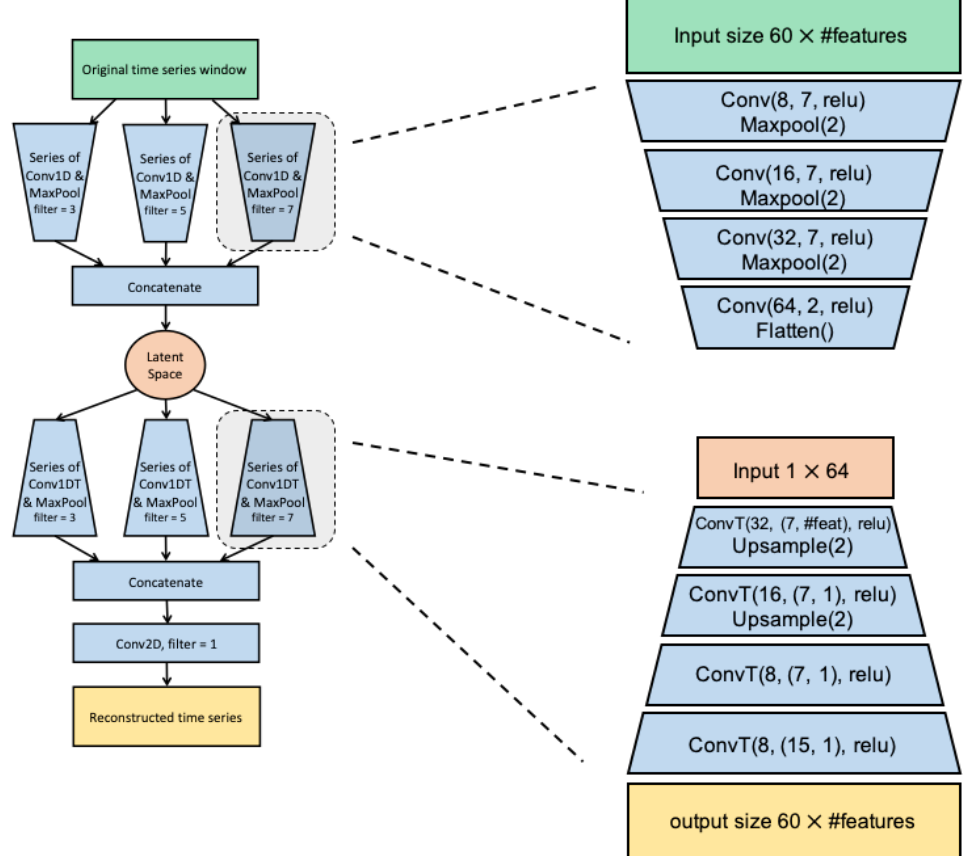
Figure 2. Network architecture of the Convolutional Variational Auto-Encoder (CVAE). On the right panels, (i) Conv depicts 1D convolution, where the first input is the channel (or filter) size, the second is the kernel size, and the third is the activation function, (ii) Maxpool refers to max pooling operation, (iii) ConvT refers to 2D transpose convolution with the first input is channel (or filter) size, the second input is kernel size, and the third is the activation function, and (iv) Upsample refers to the up